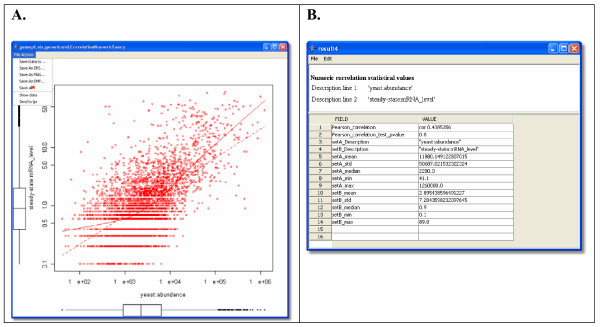
Results of a correlation analysis. A. Scatter plot of protein abundance against steady-state mRNA expression levels in yeast. The solid and dotted lines show the local polynomial loess fitting curve and the linear regression, respectively. The axes are scaled logarithmically. The box plots visualise the value distribution of each variable. B. PROMPT's spread sheet viewer with the Pearson correlation coefficient of 0.44, a highly significant p-value of 0.0 (values below 10-300 are rounded to zero), and further statistical key values. All analysis results can be exported to tab-delimited, comma separated, or Microsoft Excel files.